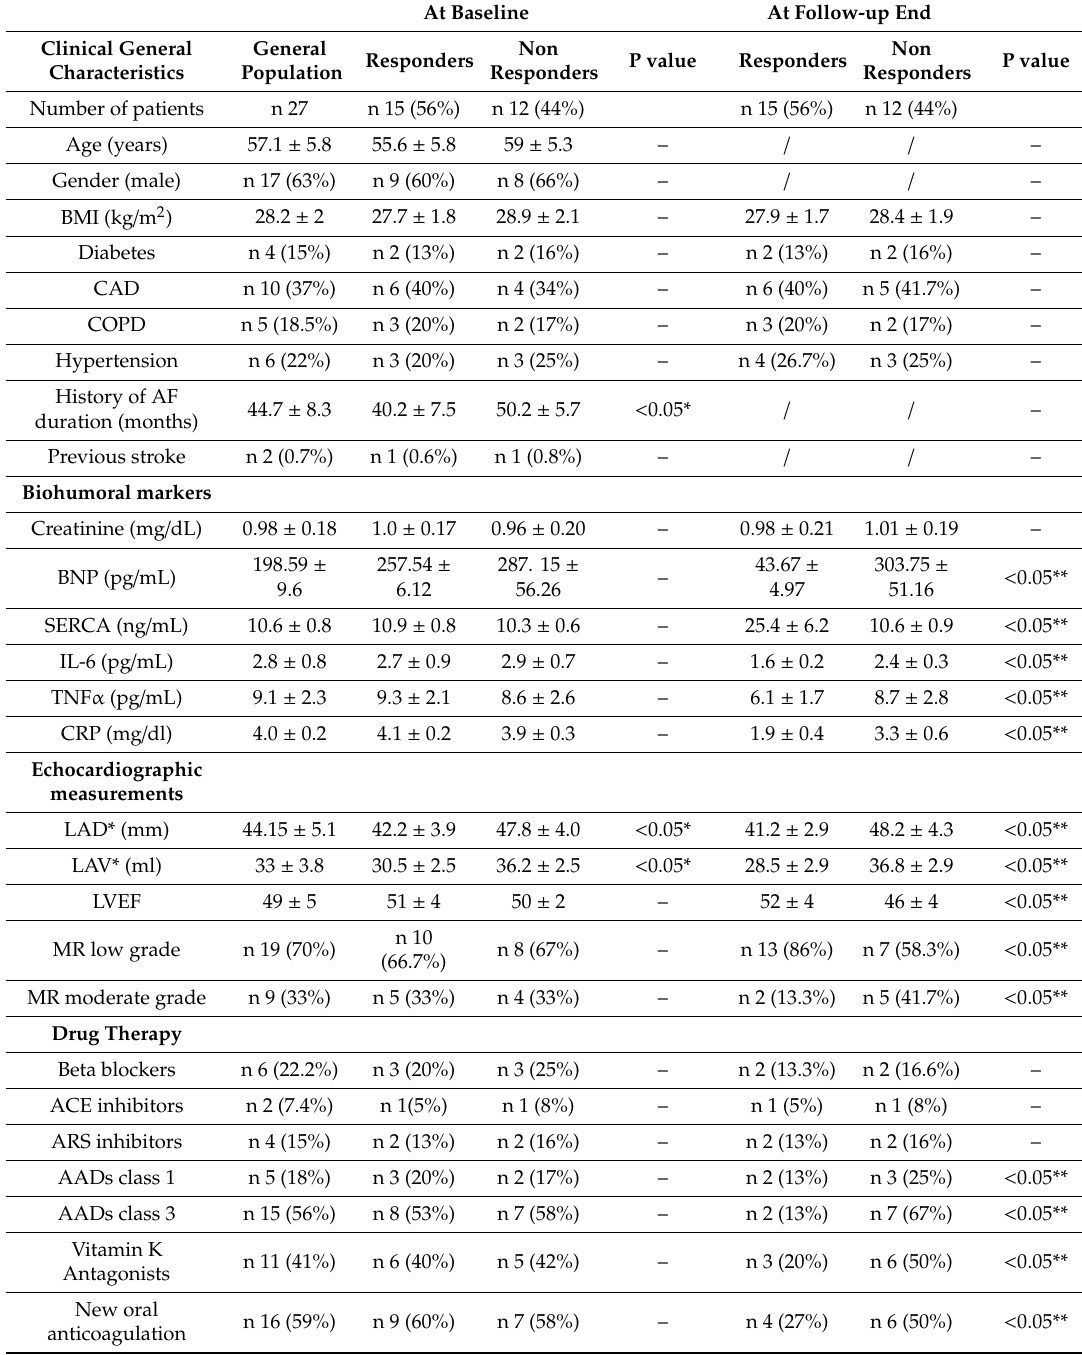
Table 1. Clinical characteristics of the study population before treatment (baseline) and at follow-up. At Baseline At Follow-up